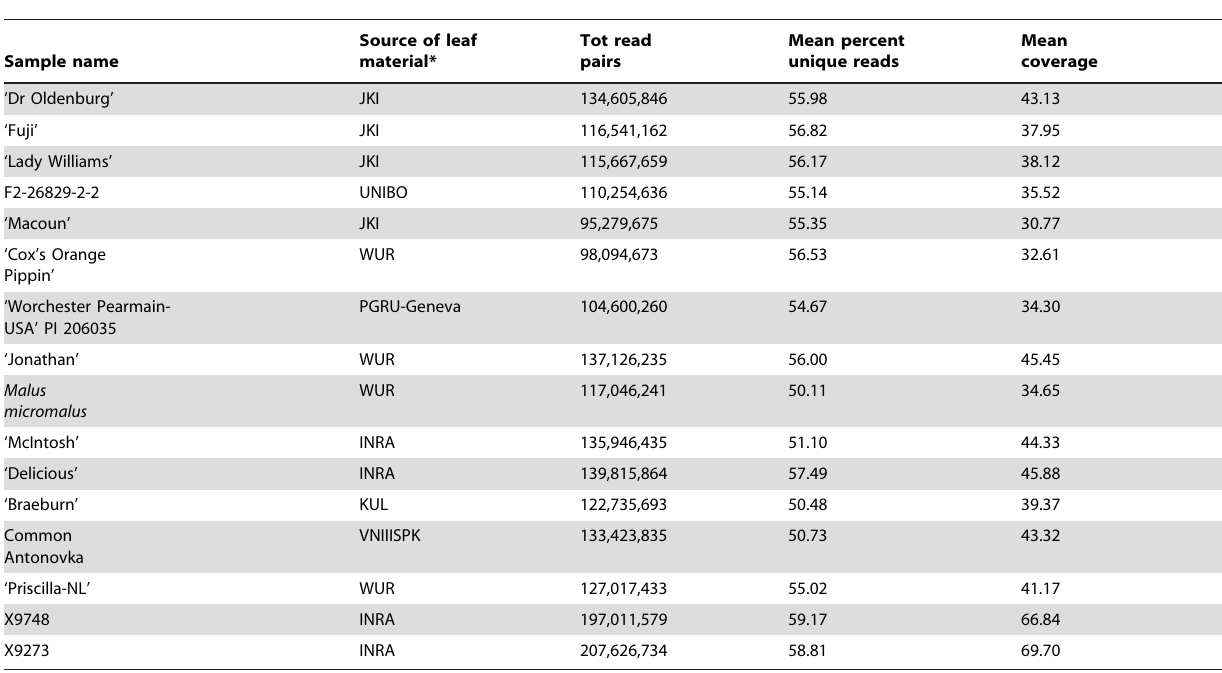
Table 1. Origin of samples and re-sequencing statistics for the 14 genotypes of the discovery panel and the two double haploids.